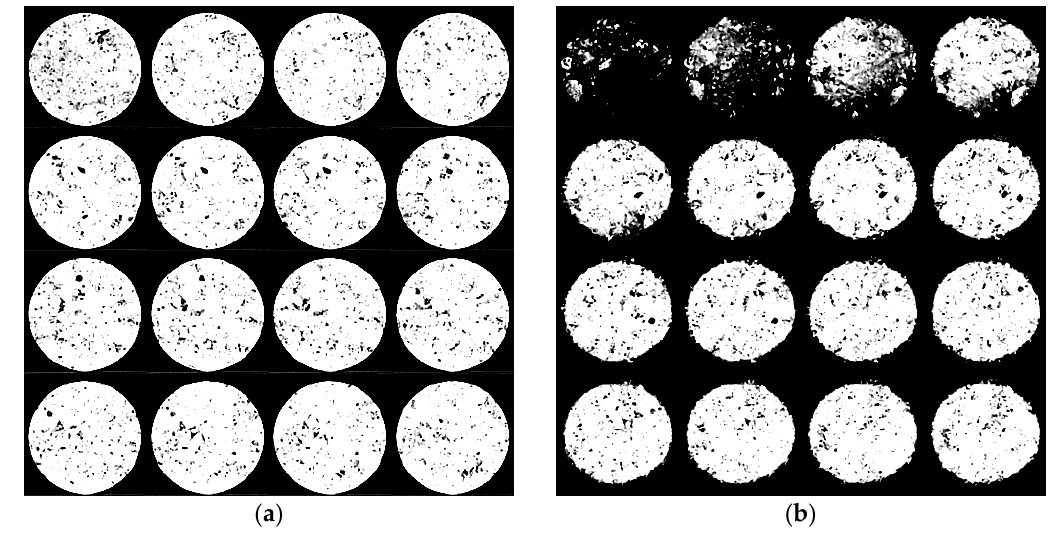
Figure 7. X-ray tomography images of uncoated samples; ( a ) before air burning; ( b ) after 6 h of exposure at 500 °C.